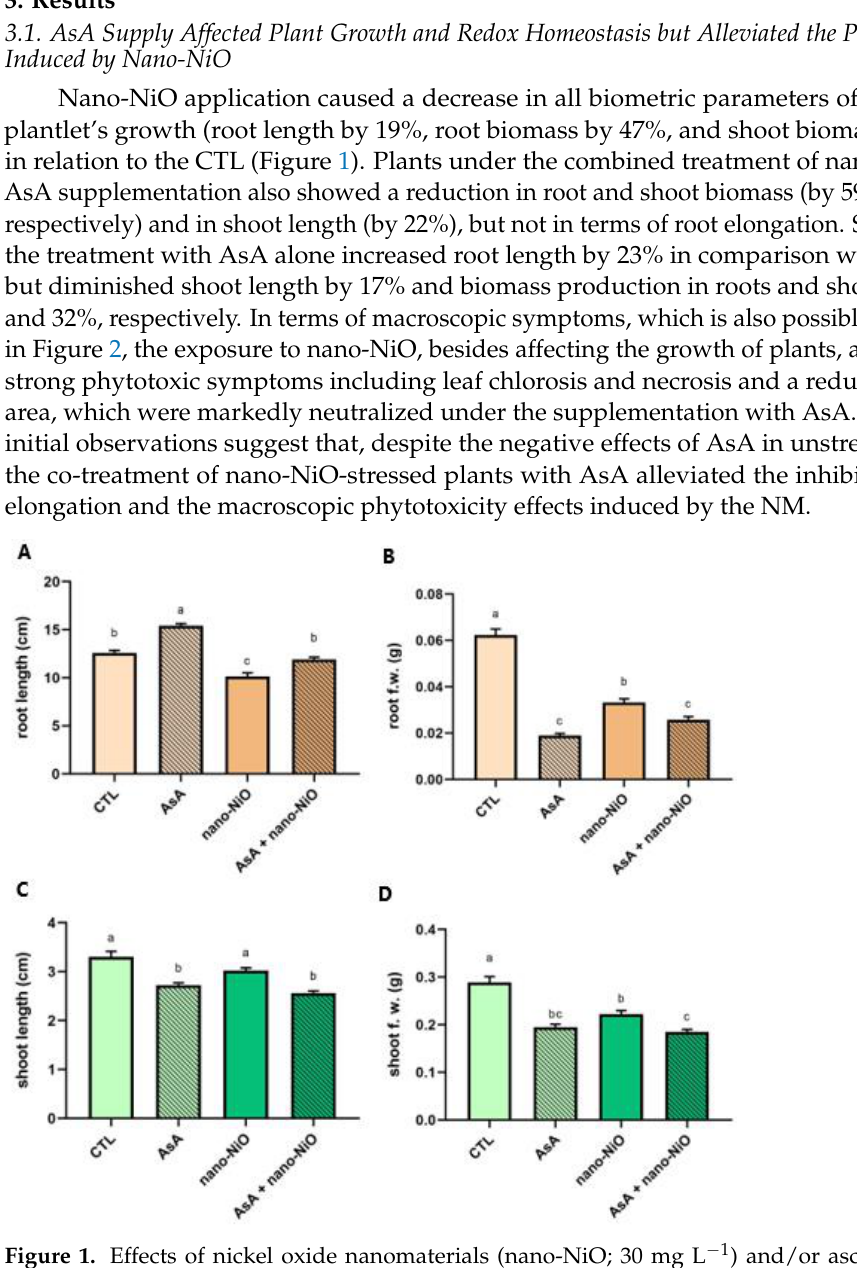
Figure 1. Effects of nickel oxide nanomaterials (nano-NiO; 30 mg L − 1 ) and/or ascorbate (AsA; 150 mg L − 1 ) on the length and biomass, expressed as fresh weight (f.w.), of roots ( A , B ) and shoots ( C , D ) of in vitro grown tomato plantlets. Data presented are mean ± SEM (n ≥ 3). Different letters above bars indicate significant statistical differences between treatments at p ≤